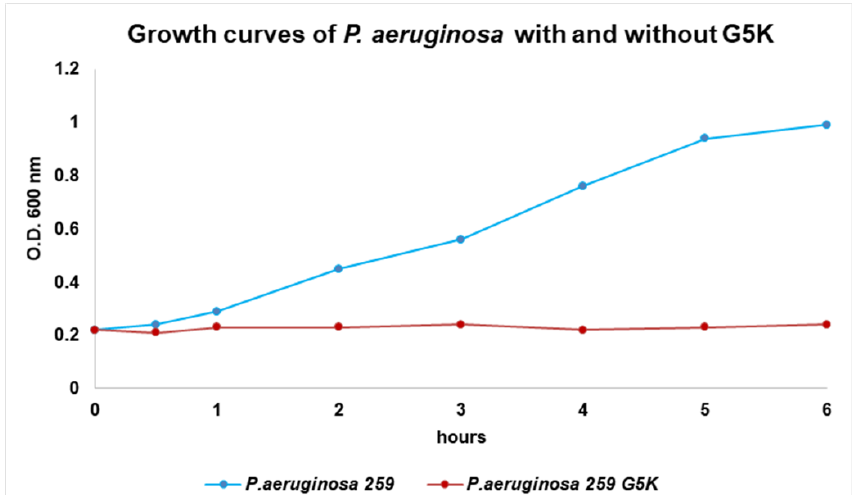
Figure 2. Effect of G5K (at 4 × MIC) on the growth curve of P. aeruginosa (strain 259) followed at 600 nm for a period of 6 h.